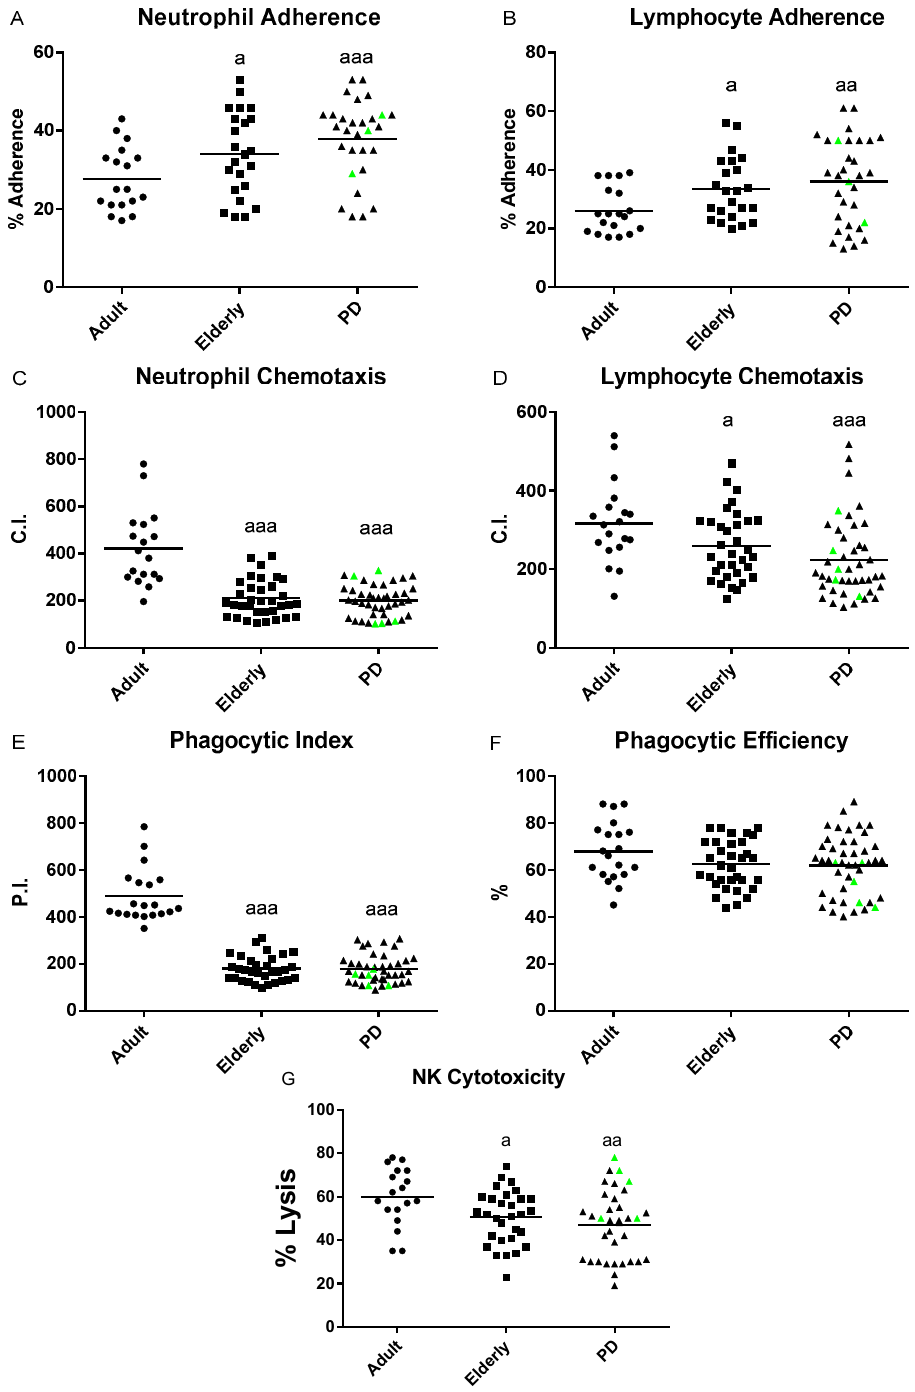
Figure 1. Immune function parameters in isolated peripheral blood neutrophils and mononuclear cells of Parkinson´s Disease (PD) stage 2 patients, and adult and elderly healthy controls. Chemotaxis index (C.I.) of ( A ) neutrophils and ( B ) lymphocytes; ( C ) phagocytic index (P.I.) and ( D ) phagocytic efficiency (%) of neutrophils and ( E ) natural killer (NK) cytotoxic activity (% lysis). Data are shown as the mean (horizontal bar) of 18–45 values corresponding to the numbers of subjects analyzed in each group (20 adults, 34 elderly, and 45 PD). Each point represents the mean of duplicate assays. The green points represent the values in five PD patients treated with levodopa. a: p < 0.05, aa: p < 0.01, and aaa: p < 0.001 with respect to the value in adult subjects.